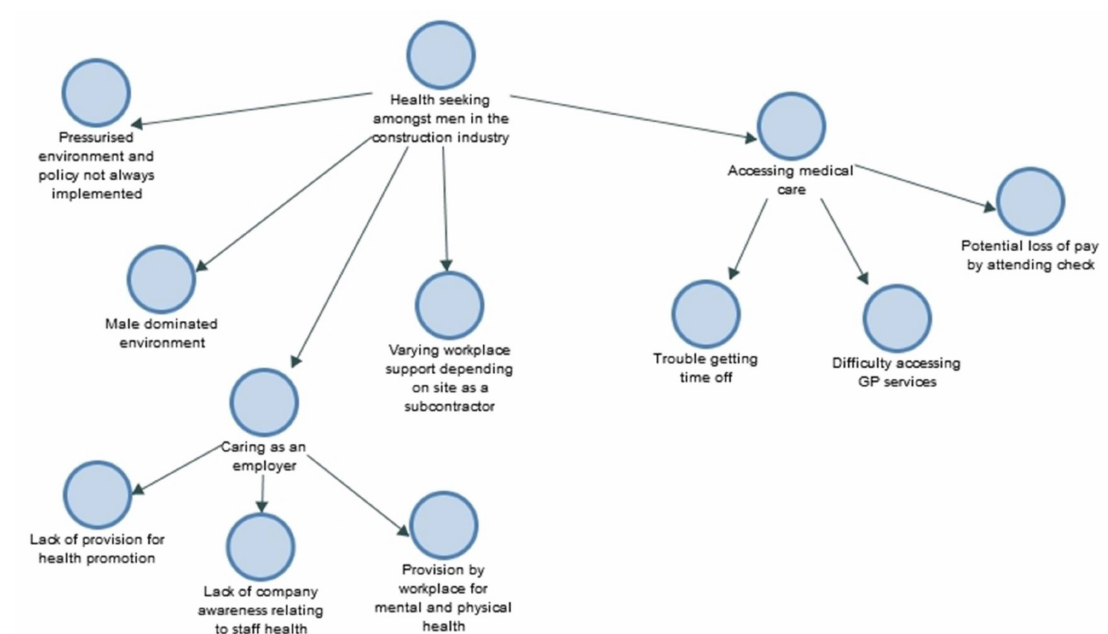
Figure 3. Theme (c): Health seeking amongst men in the construction